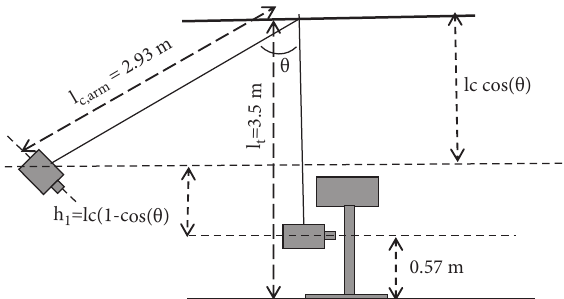
Figure 9: Experimental test impact setup. Table 2: Experimental study material properties [14].